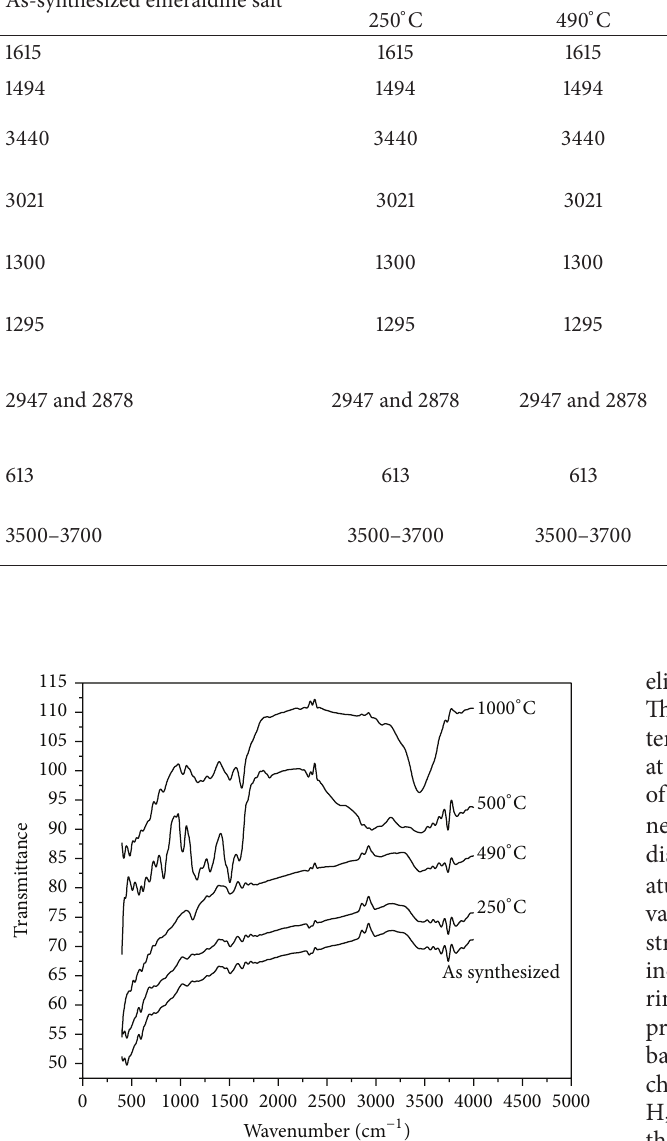
Figure 3: FT-IR spectra of untreated and heat treated emeraldine